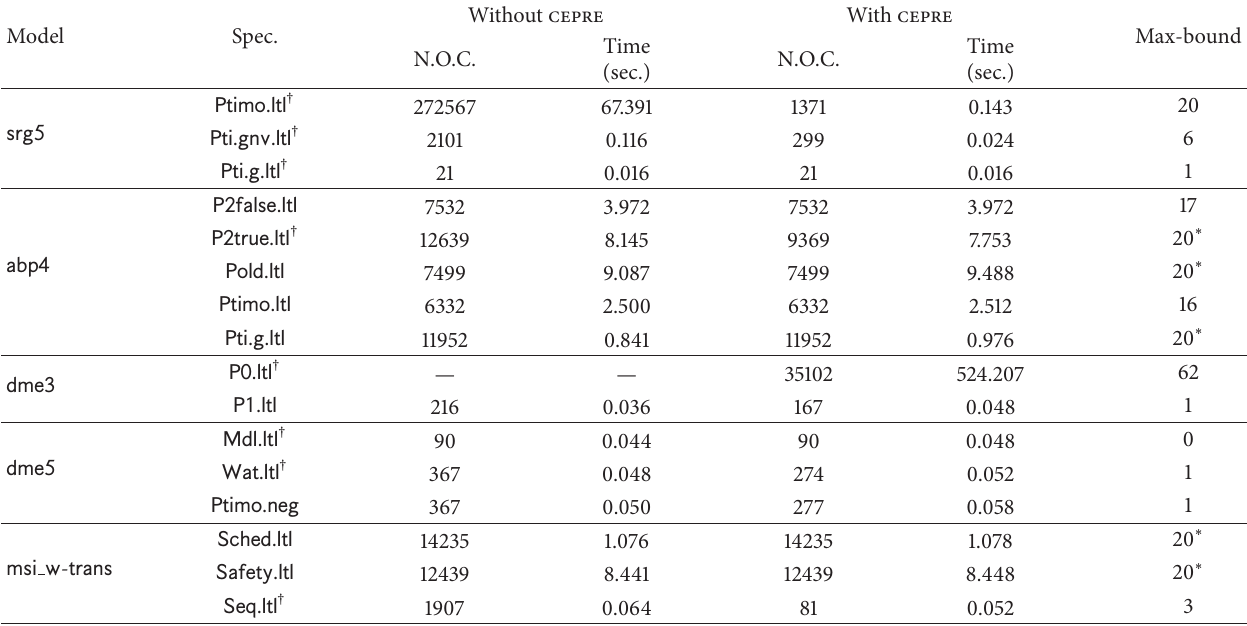
Table 10: Experimental results of BMC-based MC with/without